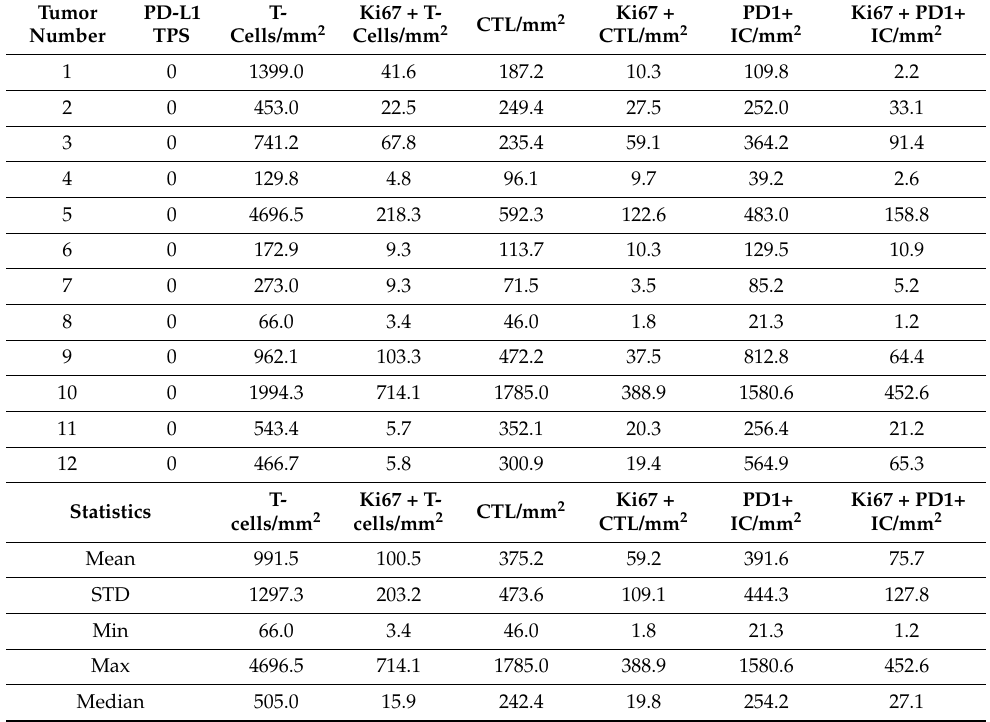
Table 2. PD-L1 status and immune cell densities and proliferation rates at